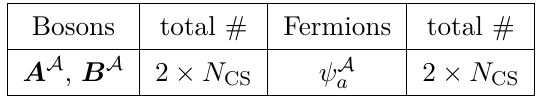
Table 1 . The summary of on-shell component fields in the CS+3PT